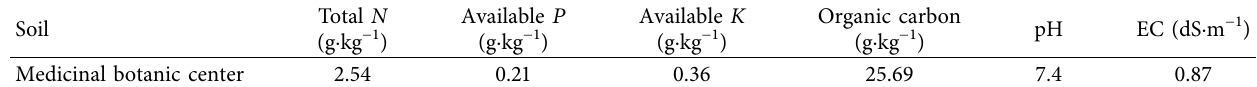
Table 1: Soil chemical characteristics of the agricultural land. Available P Available